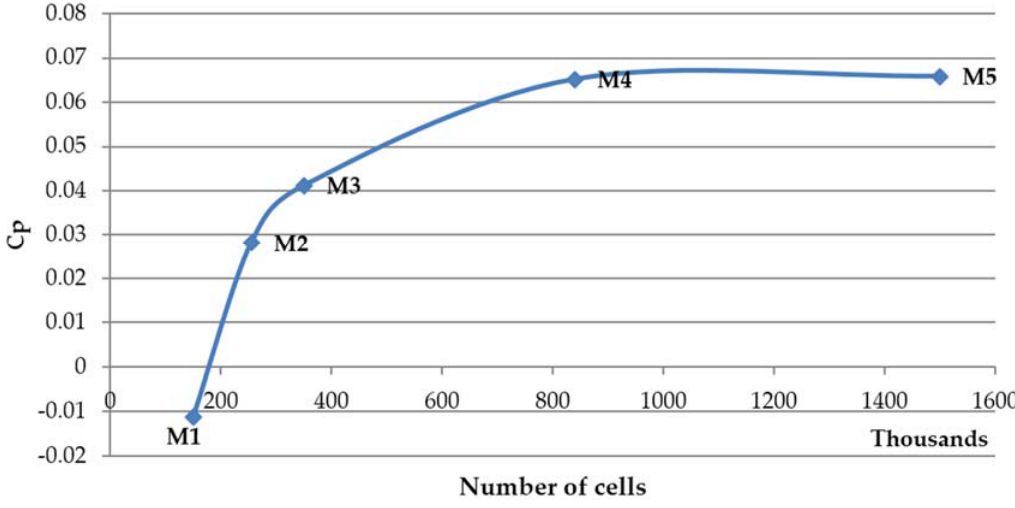
Figure 11. Variation of the C P in different types of mesh in TSR = 0.654.